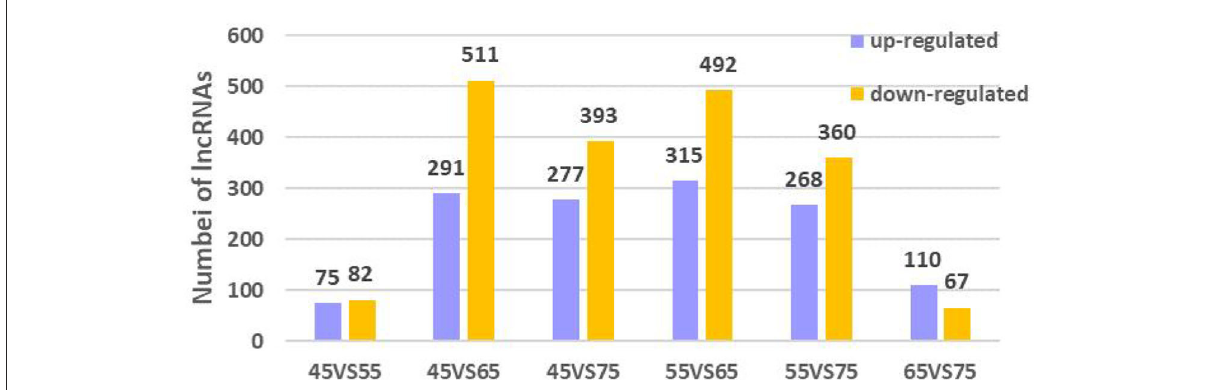
FIGURE6 Differential lncRNA expression in different embryonic stages of Inner Mongolia cashmere goats. The purple columns represent upregulated lncRNAs, and the orange column represents downregulated lncRNAs.